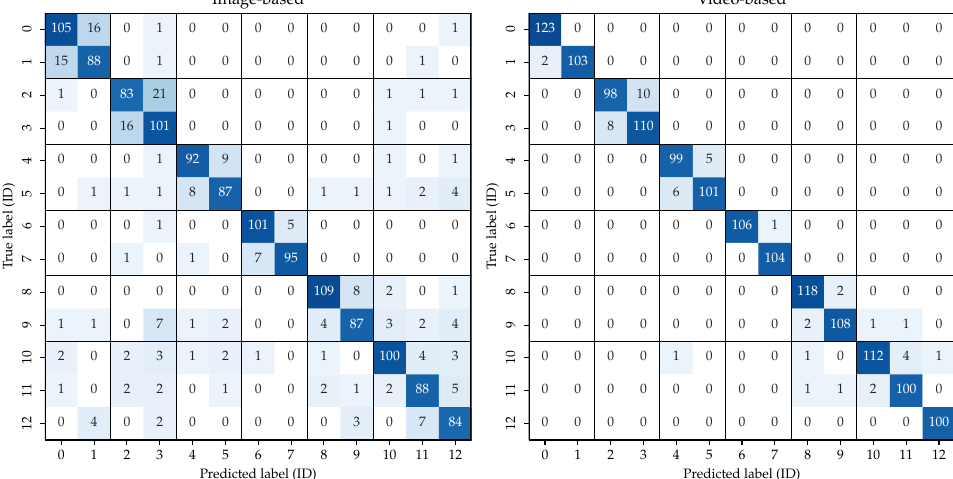
Figure 5. Confusion matrix of the two re-identification approaches. When confronted with a data sample of identity X , the model outputs a ranked list of all known identities with descending probability. Therefore, the identity Y listed first is the prediction of the model. In the case of X = Y , the model outputs the correct identity, which is shown as the entries on the diagonal of the matrix. The identities are sorted considering the respective zoos: Nuremberg (0 and 1), Berlin (2 and 3), Vienna (4 and 5), Neumünster (6 and 7), Karlsruhe (8 and 9) and Hannover (10, 11 and 12) Table 4. Performance of the video-based re-ID approach on each zoo. The rank-1 score, as well as the mean average precision (mAP), is given as a mean result of all runs of the five-fold cross-validation, including the overall standard deviation. Zoo Rank-1 mAP Nuremberg 0.991 ±